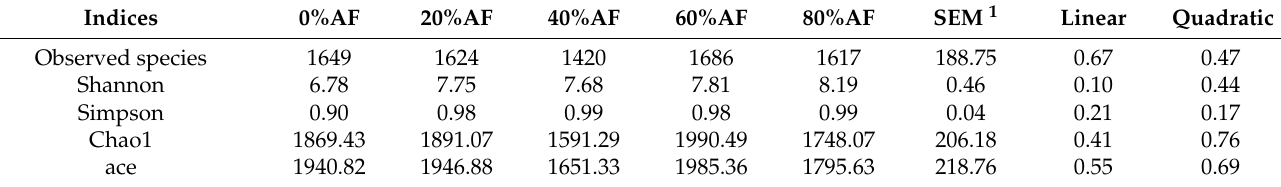
Table 4. Analysis of alpha diversity.